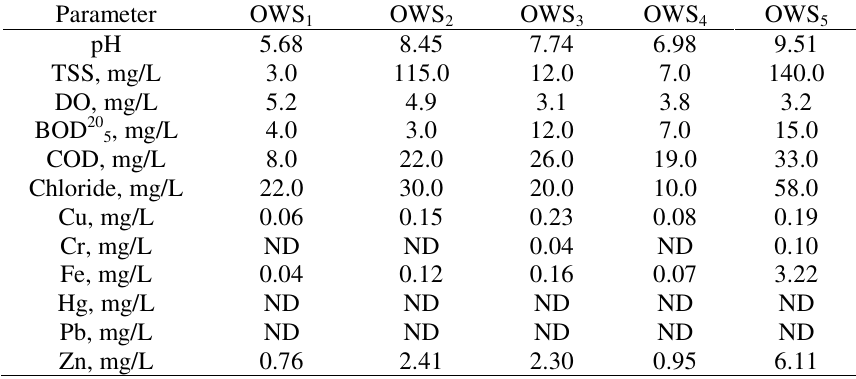
Table 2. Chemical and biological